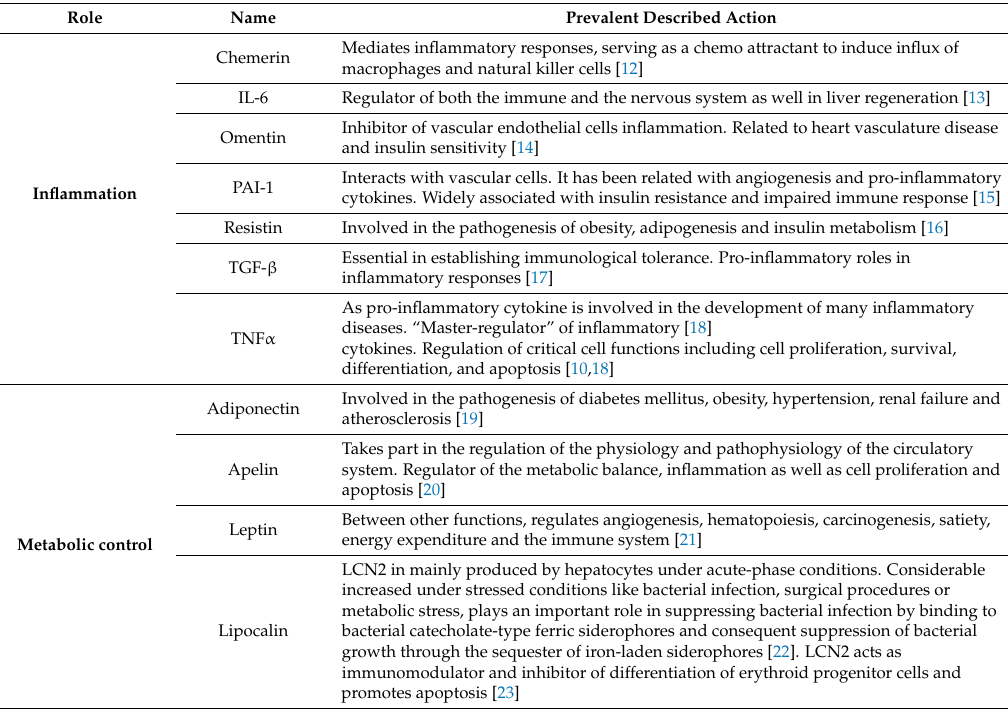
Table 1. Prevalent action of some adipokines related to liver diseases and/or